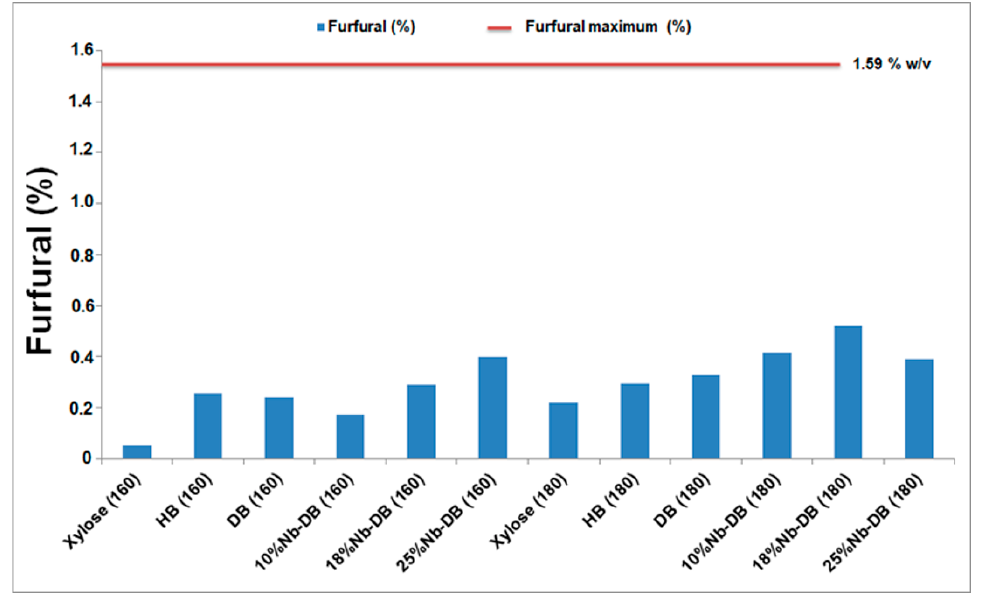
Figure 9. Produced furfural (%) during the reactions in the reagent solutions at different temperatures and using different catalysts. Maximum (%) of furfural ( — ) that could be produced in the reagent solutions, under our experimental conditions.